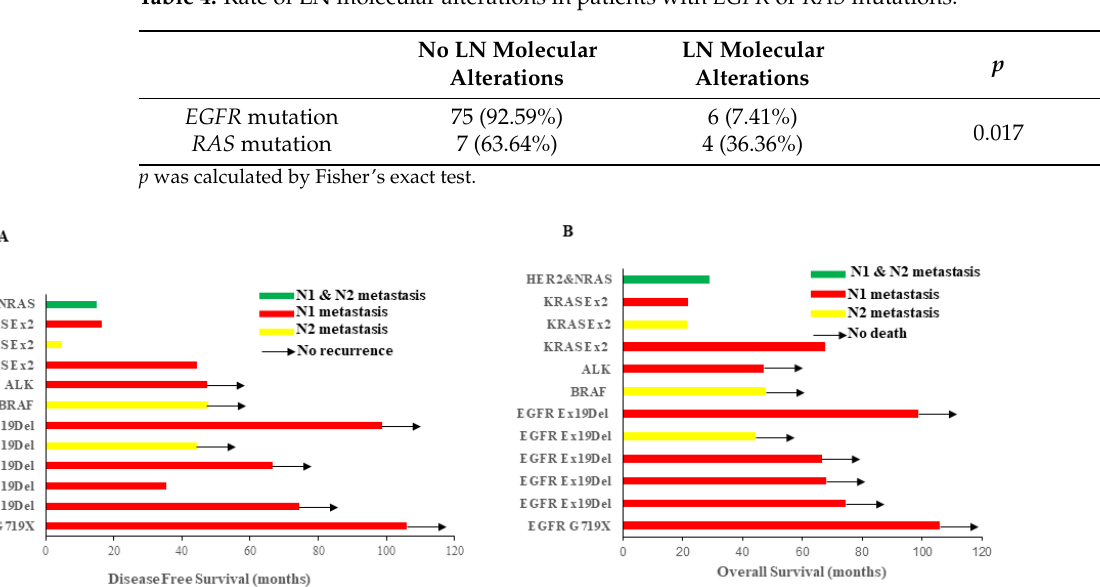
Table 4. Rate of LN molecular alterations in patients with EGFR or RAS mutations.